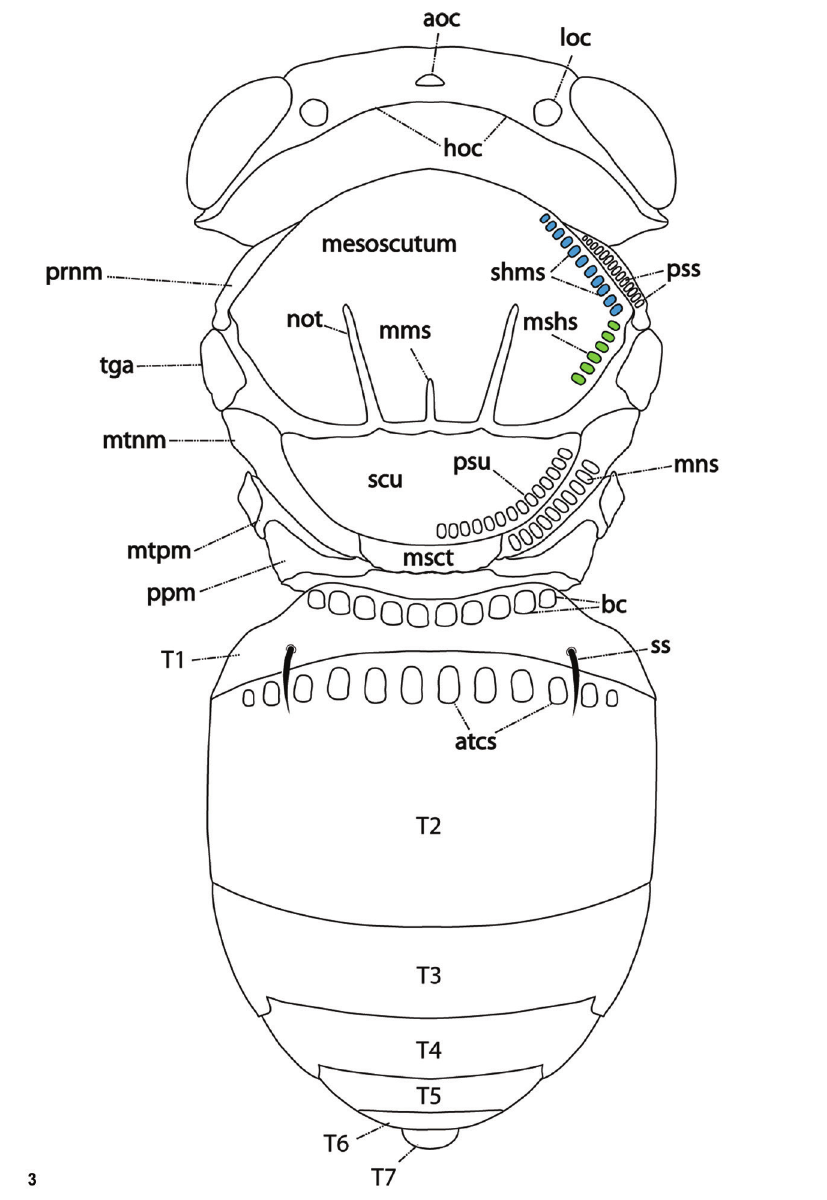
Figure 3. Line drawing of dorsal Trissolcus